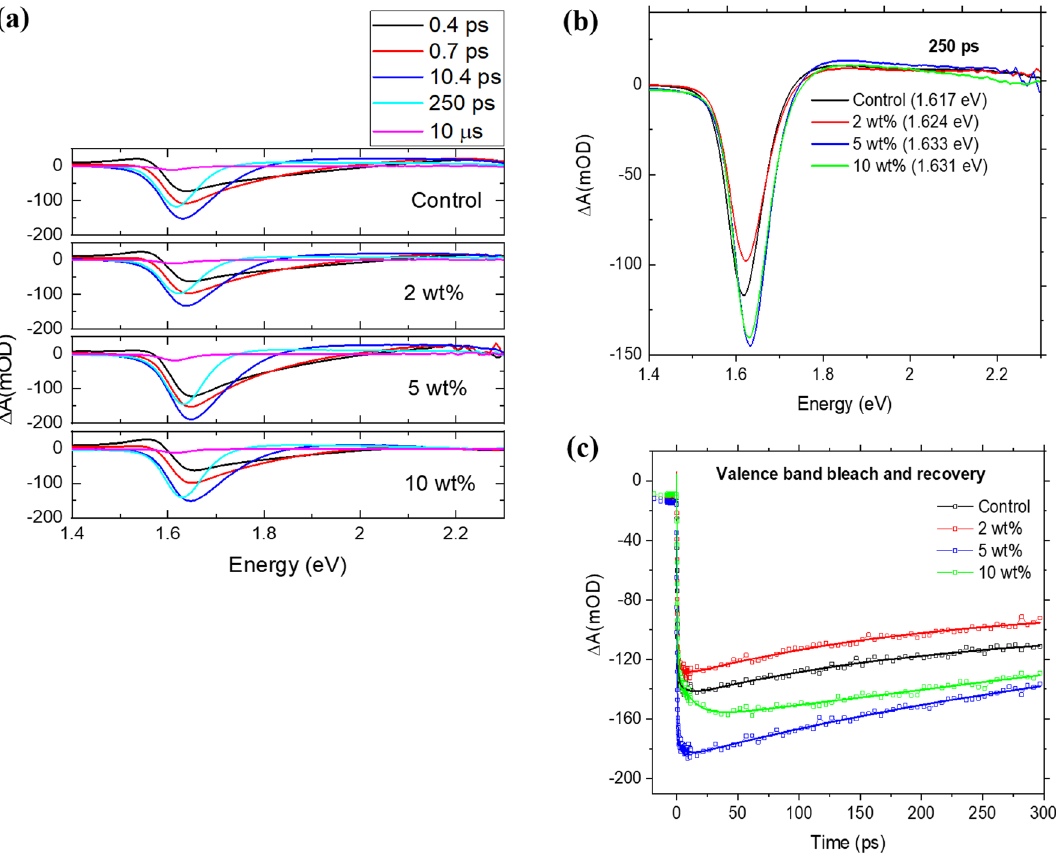
Figure 6. Transient absorption dynamics of the perovskite films with varying weight proportions of PEO: ( a ) TA spectra of the different perovskite films in the delay time range of 0.4–250 ps, ( b ) transient absorption spectra at a fixed pump-probe delay time of 250 ps and ( c ) bleach recovery kinetics of different perovskite